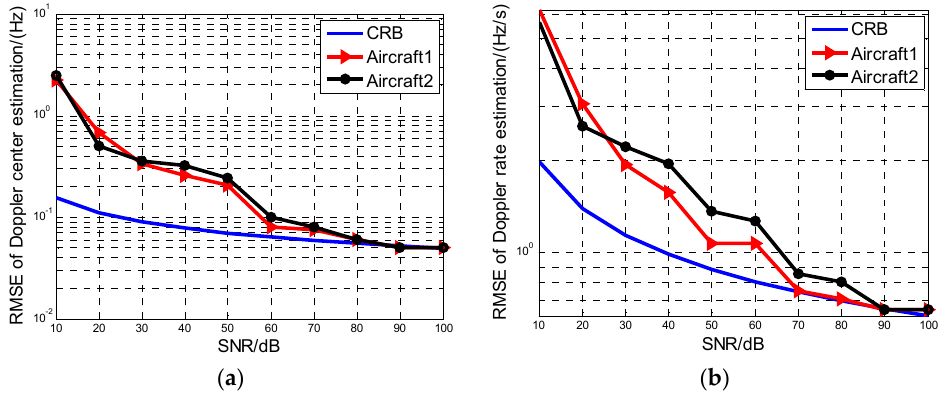
Figure 4. Estimation results of HBP compared to CRLB. ( a ) The Doppler center estimation; ( b ) Doppler rate estimation.